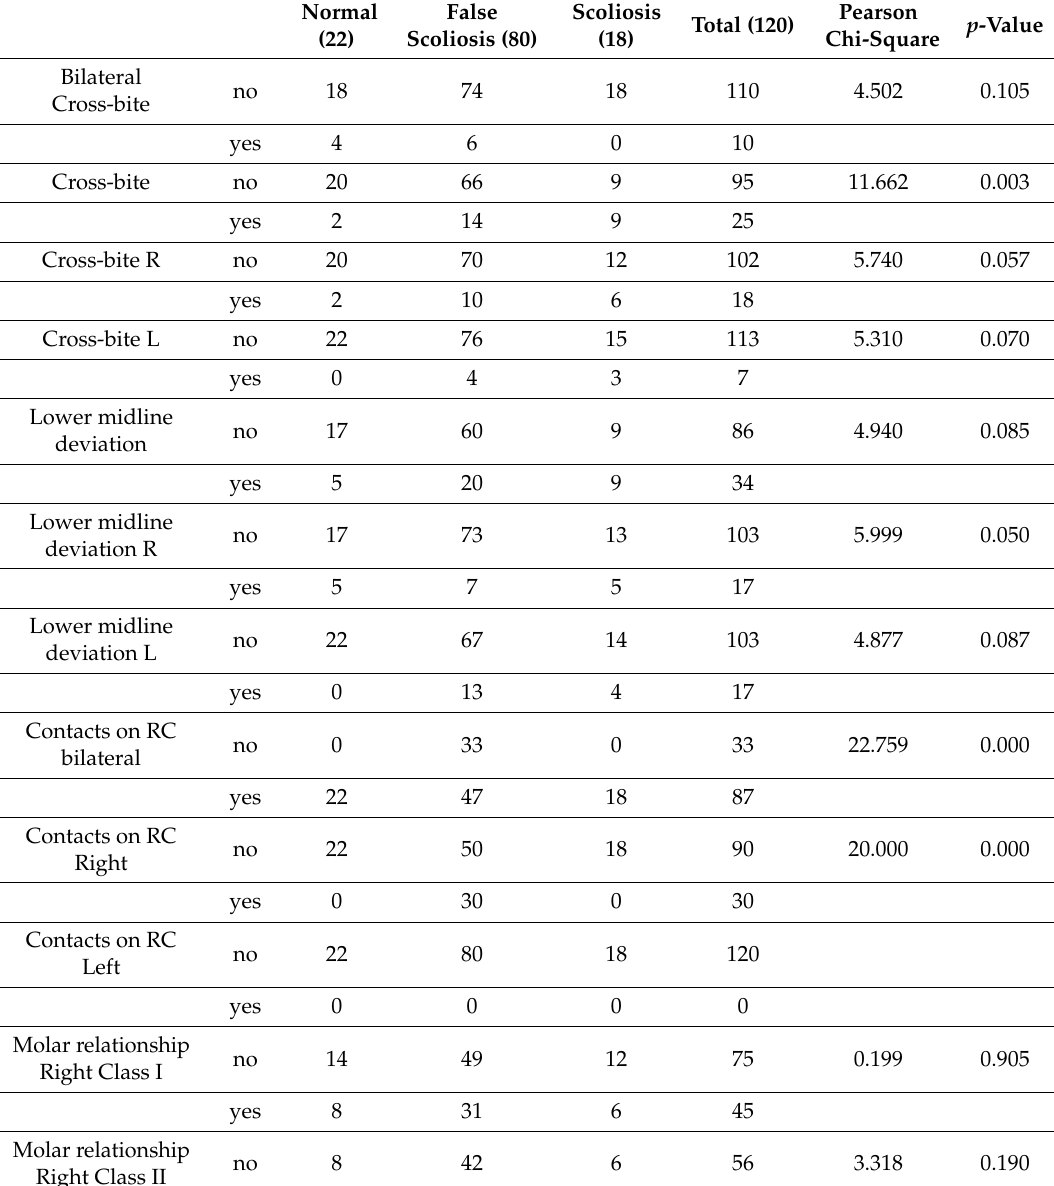
Table 5. Pearson chi-square test of our